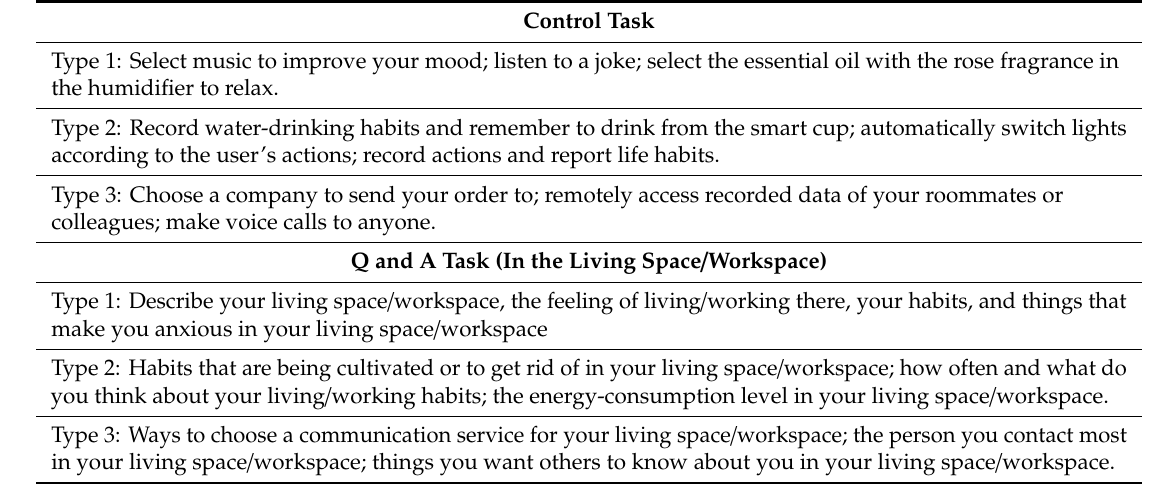
Table 1. Examples of the two tasks for the three types of functions. Control